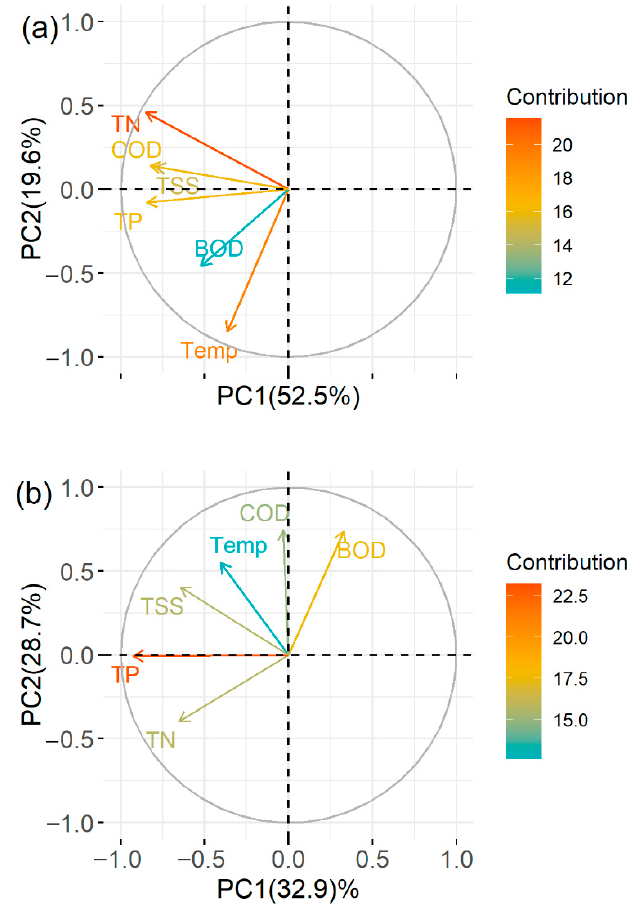
Figure 9. Biplots of results of principle component analysis (PCA) for ( a ) Pond 1 and ( b ) Pond 2 (baffled pond). In Pond 1 ( a ), all the selected water quality parameters are negatively correlated with PC1 but positively correlated with each other. In Pond 2 ( b ), TN, TP, and TSS show an inverse trend along PC1, whereas PC2 has higher loadings in temperature, BOD, and COD and shows a positive relationship.